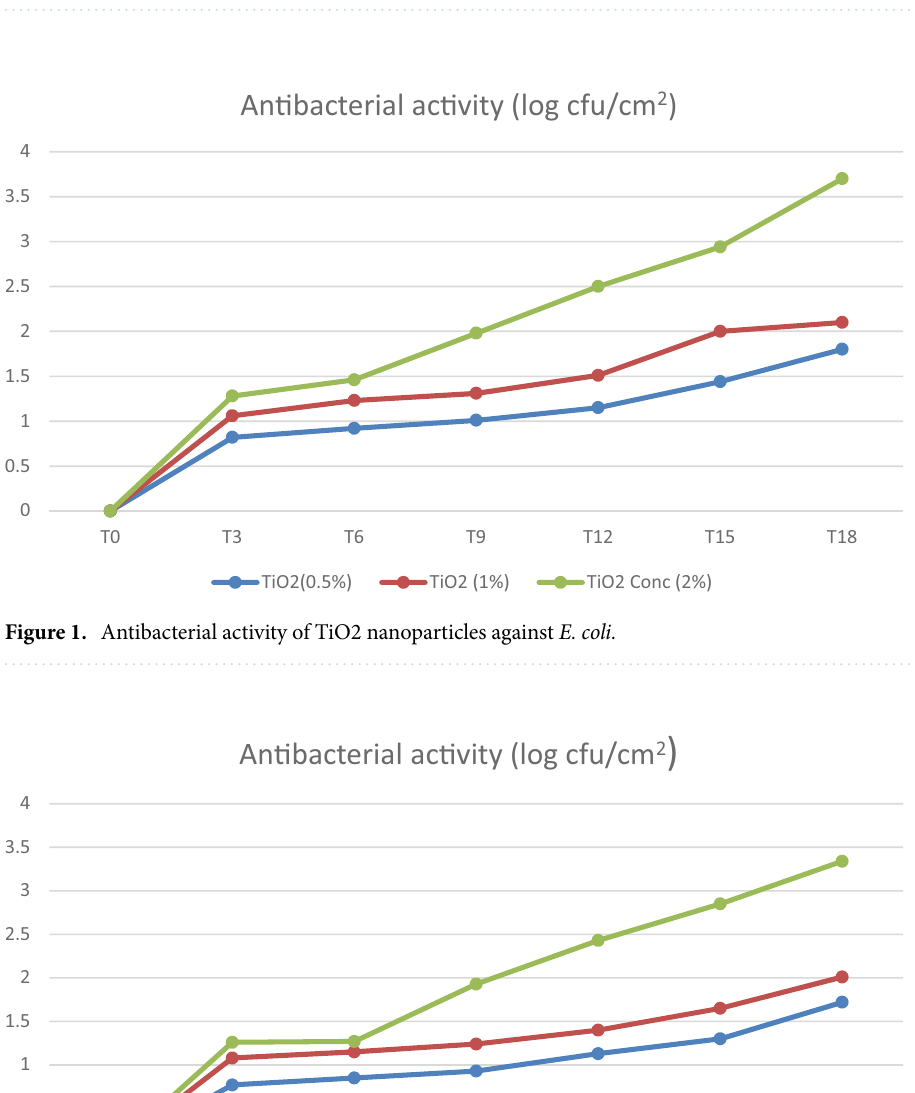
Table 4. Antibacterial activity (reduction) after exposure to different TiO2 concentrations.